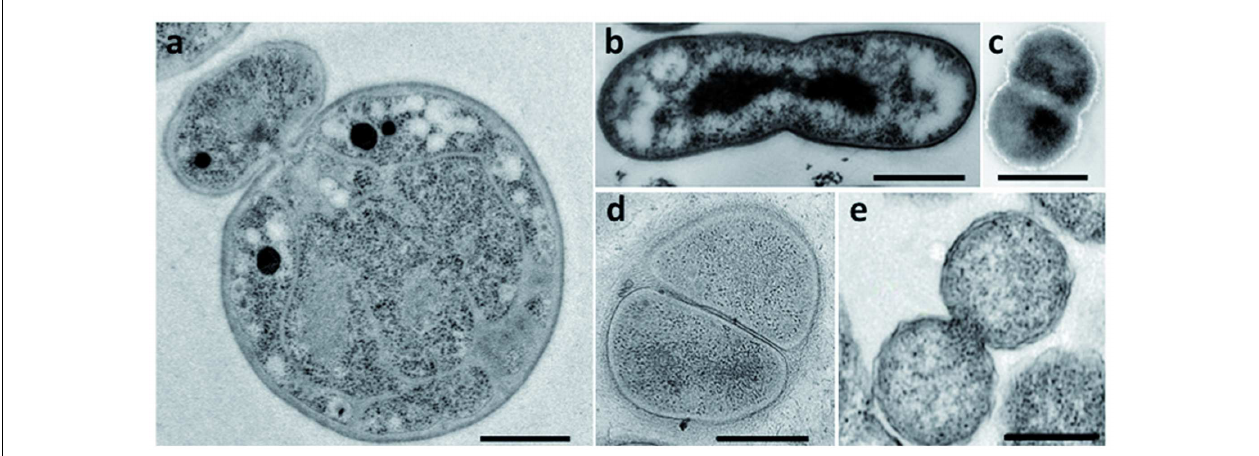
FIGURE 2 | Division modes in the PVC superphylum. Transmission electron micrographs of thin sections of dividing cells from (a) G. obscuriglobus (Santarella-Mellwig, personal communication), (b) Chthoniobacter flavus [adapted with permission from Sangwan et al. (2004), License number 3662961133966], (c) L. araneosa [adapted with permission from Cho et al. (2004), License number 3662980203389], (d) P. mikurensis [reprinted with permission from Fukunaga et al. (2009)], and (e) C. trachomatis [adapted with permission from Lewis et al. (2014)]. Scale bars, 0.5 µ m.